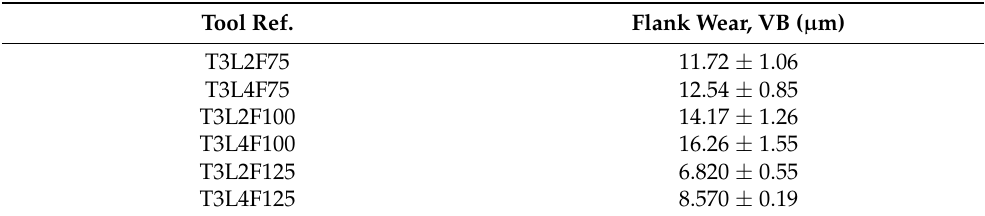
Table 14. VB values obtained from measurements performed on the clearance faces of T3 tools. Tool Ref.